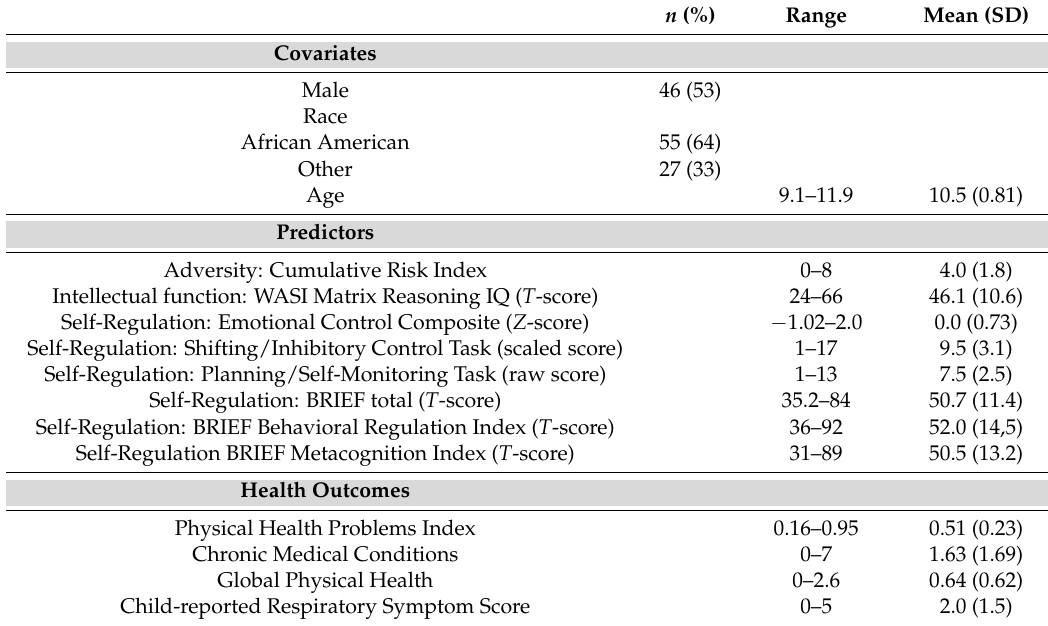
Table 2 details participants’ psychosocial adversity that comprised the Cumulative Risk Index. Table 1. Distribution of Children’s Demographics, Risk, Self-Regulation, and Health ( n = 86).